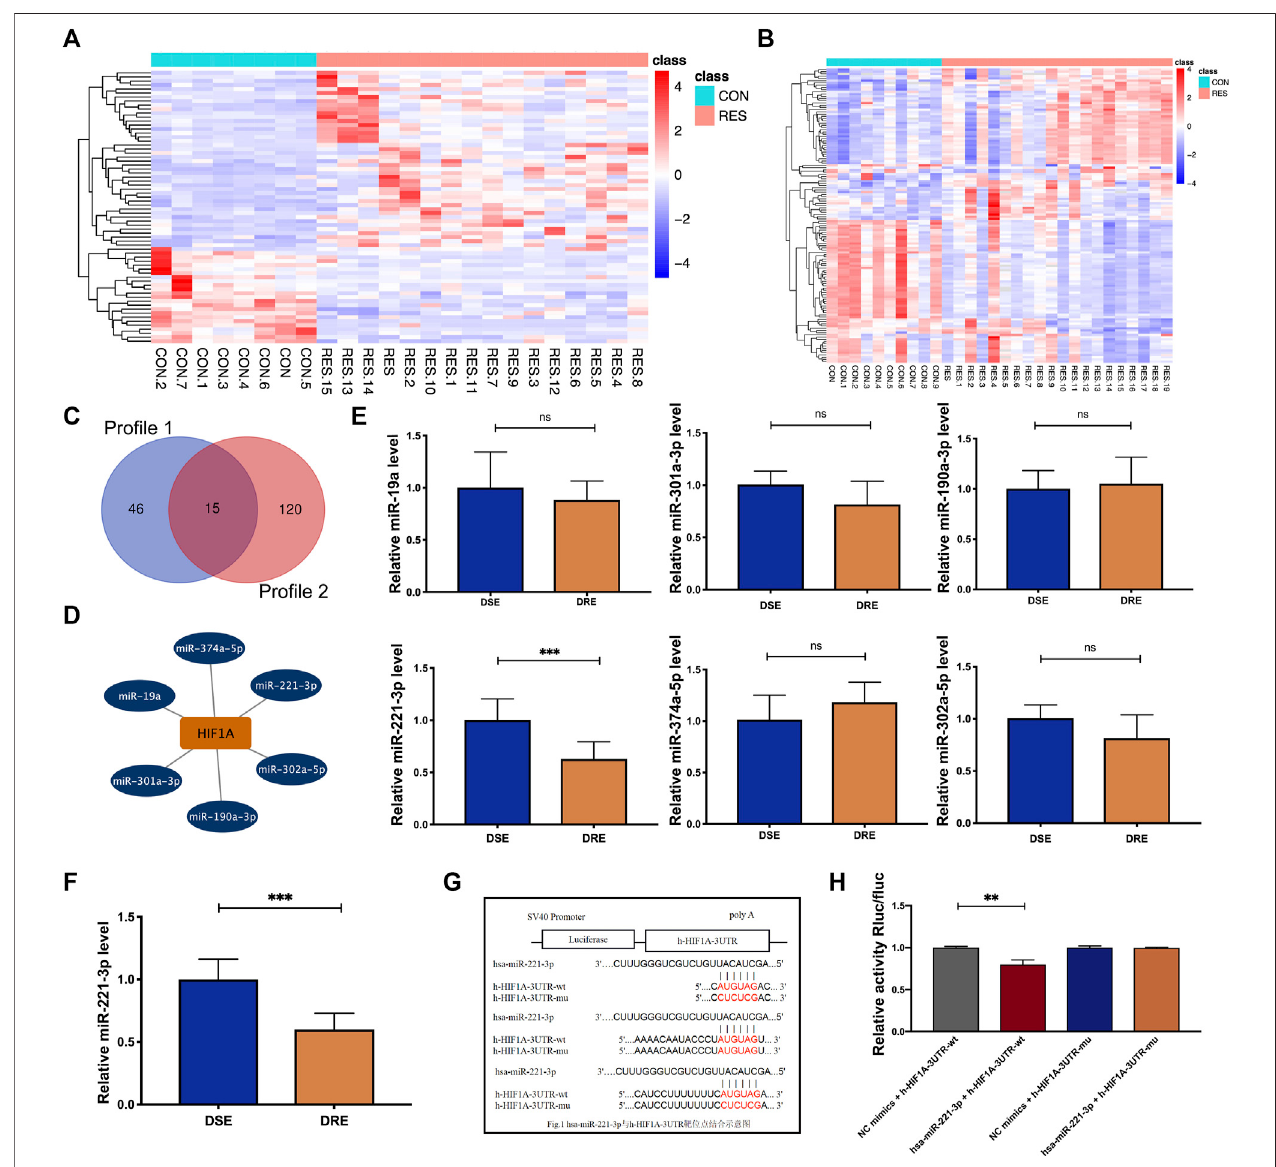
FIGURE 6 | Identi fi cation of the miRNA regulating HIF-1 α expression in VAP-resistant epilepsy. (A) Heatmap of the 71 differentially expressed miRNAs of Pro fi le 1. (B) Heatmap of the 135 differentially expressed miRNAs of Pro fi le 2. (C) Pro fi le 1 and Pro fi le 2 had 15 intersected differentially expressed miRNAs screened by a Venn diagram. (D) The starbase database predicted that six differentially expressed miRNAs (miR-374a-5p, miR-221-3p, miR-302a-5p, miR-190a-3p, miR-301a-3p, and miR-19a) potentially regulate the expression of HIF-1 α . (E) MiR-221-3p was reduced signi fi cantly in the blood of children with VPA-resistant epilepsy compared with that of children with VPA-sensitive epilepsy. There is no signi fi cant difference in miR-374a-5p, miR-302a-5p, miR-190a-3p, miR-301a-3p and miR-19a between VPA-sensitivegroupandVPA-resistantgroup(DSE: n (cid:1) 8;DRE:n (cid:1) 16). (F) MiR-221-3pinhippocampusofVPA-resistantgroupwassigni fi cantlylowerthanthatinVPA- sensitivegroup ( n (cid:1) 6). (G) The predictedbinding sites of miR-221-3p in the 3 ′ -UTR ofHIF-1 α wasveri fi ed by luciferase reporter gene assay. (H) Dual luciferase reporter gene assay demonstrated that miR-221-3p could negatively regulated the expression of HIF-1 α . Values are the mean ± S.D. Unpaired t -test. * p < 0.05, ** p < 0.01, and *** p < 0.001. DSE: VPA-sensitive epilepsy and DRE: VPA-resistant epilepsy. NC: negative control, Wt: wild type, and Mut: mutant.